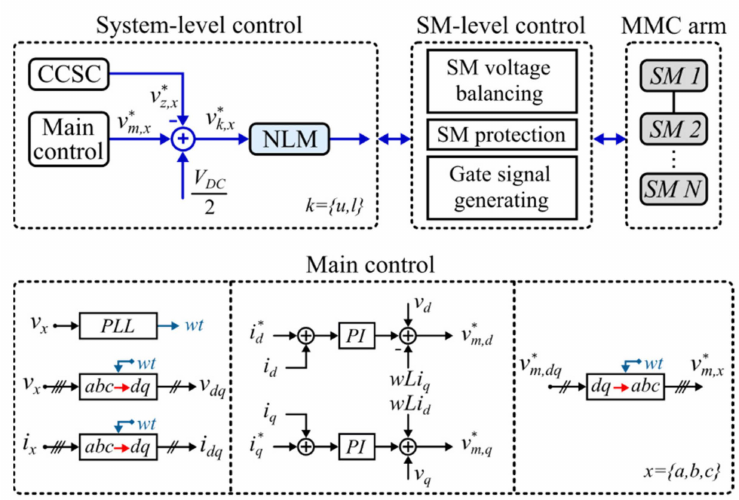
Figure 3. MMC control structure.